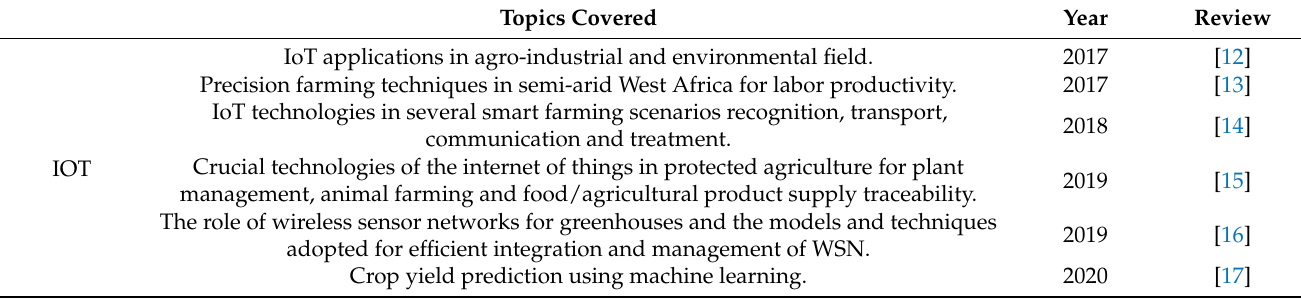
Table 1. Recent review paper in the agricultural domain using machine learning. Topics